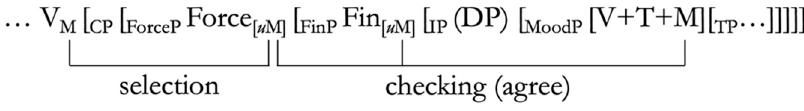
Figure 1. Syntactic analysis adapted from Iverson et al. (2008, p. 139) .